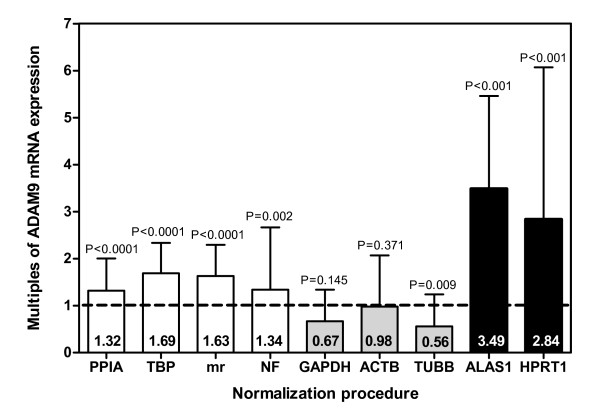
ADAM9 mRNA expression in malignant tissue samples compared to non-malignant paired samples in depending on different normalization approaches. Gene expression in the matched malignant tissue samples was calculated as multiple of the expression in the non-malignant sample that was set 1.0. The columns represent the median and interquartile ranges of the multiple gene expression. The four blank columns result from ADAM9 mRNA expression related to the two non-regulated reference genes (PPIA, TBP) and to the normalization factors (mr, of the two genes; NF, calculated using geNorm; see text). The three striped and two black columns illustrate the normalization of ADAM9 expression using either up-regulated (GAPDH, ACTB, and TUBB) or down-regulated (ALAS1 and HPRT1) genes.